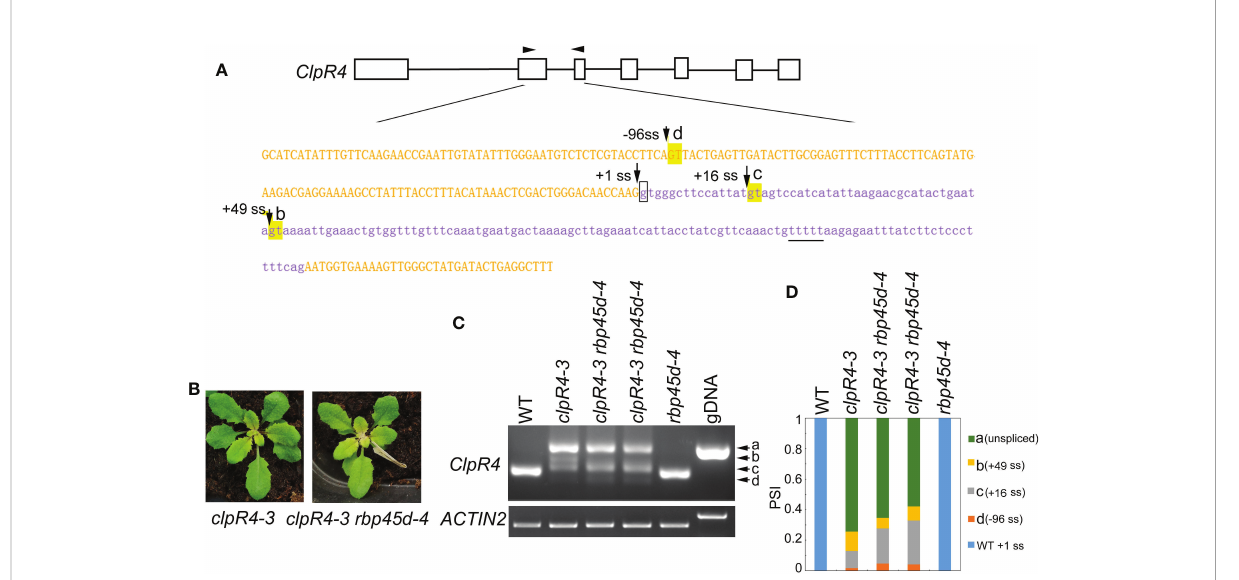
FIGURE 7 RBP45d regulates the cryptic 5 ’ splice site selection and splicing ef fi ciency of ClpR4 intron 2 in clpR4-3 . (A) Schematic diagrams of the ClpR4 gene and sequences of ClpR4 exon 2 and intron 2. The black boxes indicate exons and the black lines indicate introns. Upper and lower case letters indicate exon and intron sequences, respectively. The arrows labelled with d, c and b indicate the activated cryptic 5 ’ splice sites at the -96 ss, +16 ss, and +49 ss, respectively. The arrow labelled with +1 ss indicates the authentic splice site, and boxed g indicates the point mutation in clpR4-3 . The arrowheads indicate the primers used for RT-PCR. The T-rich sequence downstream the splice site +49ss is underlined. (B) Phenotype of clpR4-3 and clpR4-3 rbp45d-4 mutants. (C) Splicing patterns of ClpR4 intron 2 in WT, clpR4-3 and clpR4-3 rbp45d-4 plants. Band a corresponds to the transcript retained intron 2, whereas band b, c and d correspond to the transcripts spliced at +49 ss, +16 ss and -96 ss, respectively. ACTIN2 is used as an internal control. Two biological replicates (independent pools of aerial parts of plants) were analyzed, and one representative result is shown. (D) Relative levels of the PCR product bands in (C) quanti fi ed by ImageJ software. PSI (percent spliced in index) indicates the percentage of each variant in total